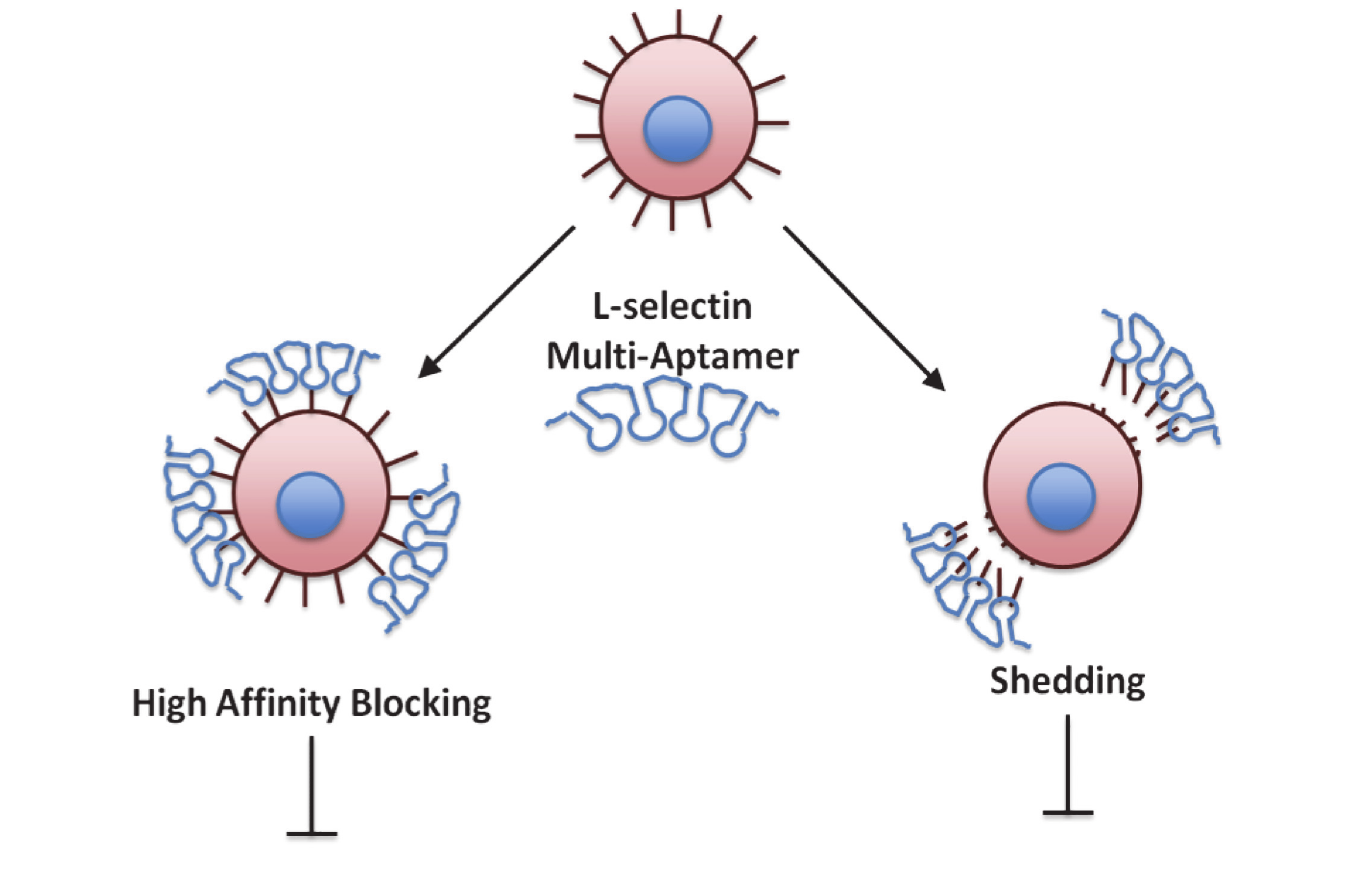
Fig 1. Potential mechanisms of action of multivalent interactions with L-selectin. We hypothesize that the Multi-Aptamer may either inhibit L-selectin function via high affinity, multivalent binding to L-selectin or by inducing shedding of surface L-selectin via multivalent interactions.